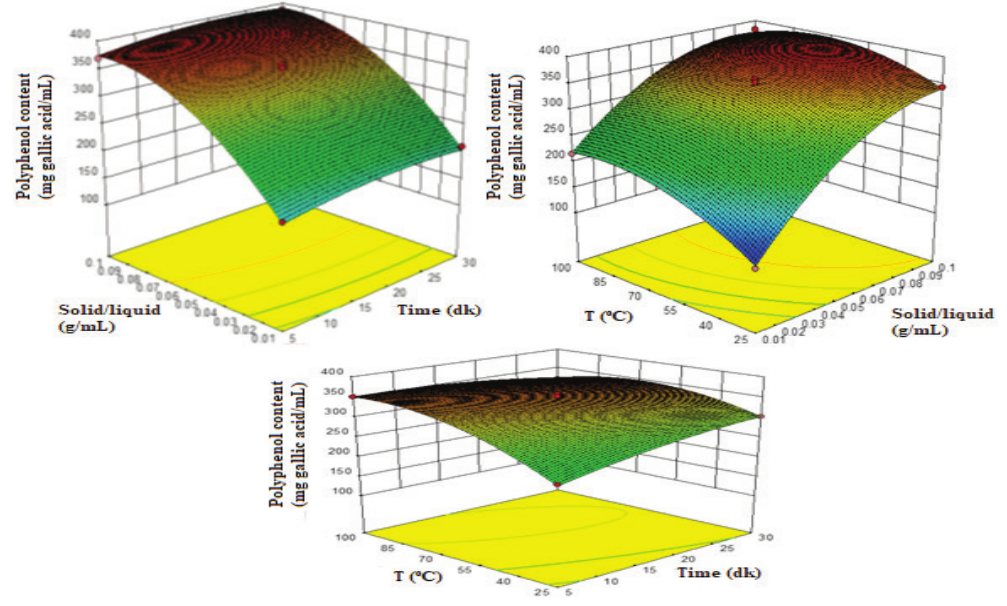
Figure 1: . 3-D graph showing the total polyphenol content in the black tea extract a) solid / liquid ratio and variation with time, b) temperature and variation with solid/liquid ratio, c) temperature and variation with time.